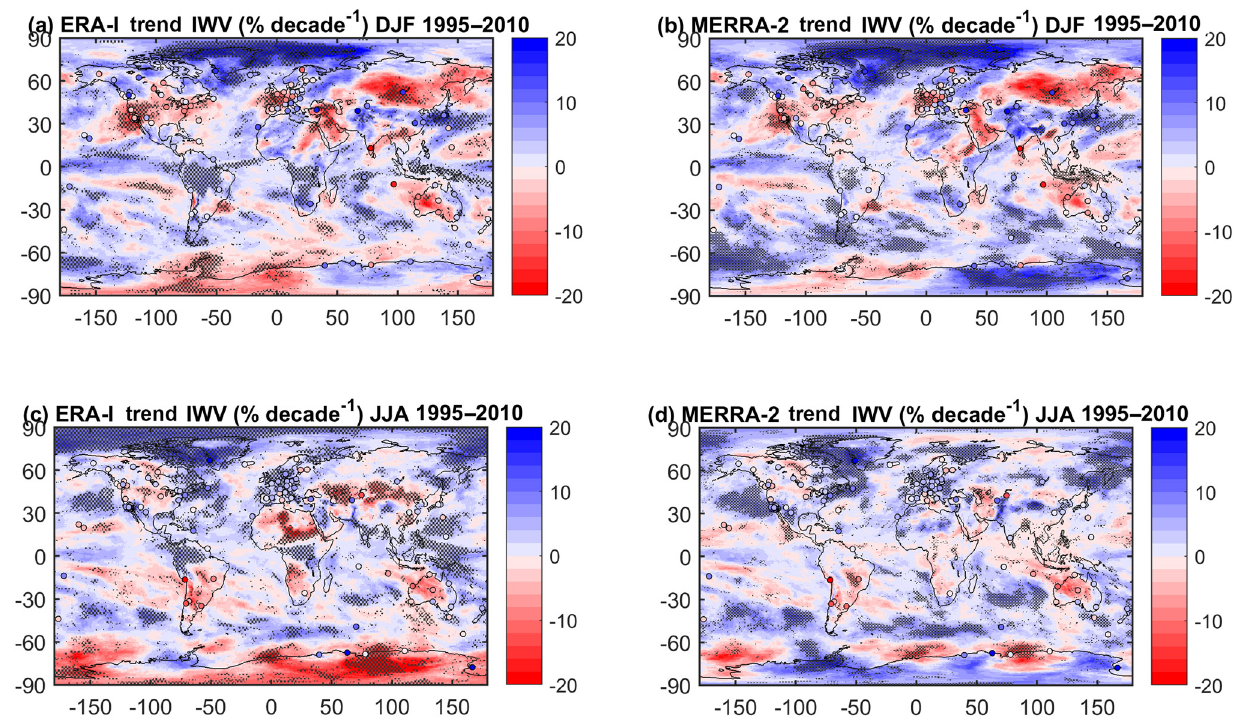
Figure 6. Seasonal IWV trends for the 1995–2010 period from ERA-Interim (shading) and GPS (filled circles) for DJF (a) . (b) Same as panel (a) but for MERRA-2. The statistically significant trends from the reanalyses are highlighted by stippling. (c) Same as panel (a) but for JJA. (d) Same as panel (b) but for JJA. The statistically significant trends from the reanalyses are highlighted by